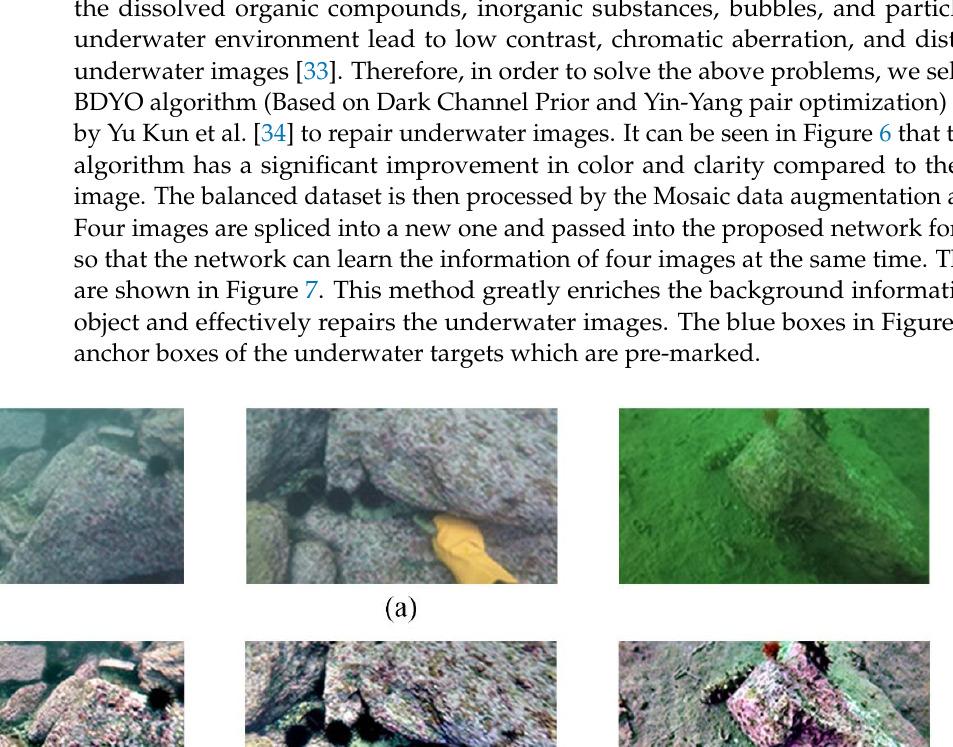
Figure 7. Schematic diagram of the Mosaic algorithm. 4. Experimental Settings 4.1. Experimental Environment The experimental environment includes IntelXeonE3-1220V6 @3.00 GHz quad-core processor, 32GB RAM, and Nvidia GTX2080 Ti. All experiments were performed using CUDA 10.2 on PyTorch 1.5.1, Python 3.7, and Windows 10 platforms. The algorithm is written in the Windows 10 platform using the PyTorch framework. 4.2. Experimental Datasets (a) Original image dataset: The underwater image labeling dataset provided by the official website of UPRC 2021. This dataset provides underwater target images of holo- thurian, echinus, scallop, and starfish, as well as their position coordinates in the images. There is a total of 5543 underwater optical images in .jpg format, with 4743 images in the training dataset and 800 images in the test dataset. (b) Underwater data augmentation processing dataset: To balance the dataset, the original image is magnified by 1.5 times, and target extraction is performed using a sliding window of the same size as the original image. However, the dataset has an excessive amount of echinus, and there are numerous images with only one scallop, which easily leads to overfitting of the training model. Therefore, the sliding window must be limited: no enhancing processing is conducted if the sliding window comprises sea urchins or only